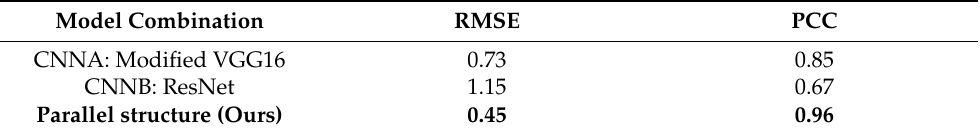
Table 4. Comparison of the proposed approach with other state-of-the-art methods.